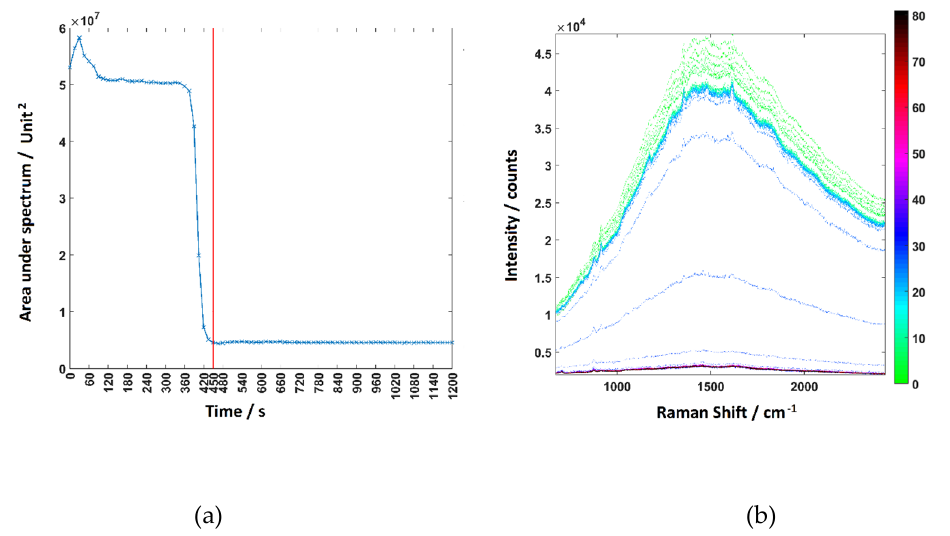
Figure A3. ( a ) The area under the curve of each spectrum in (b) plotted against time. ( b ) Raman spectra of the fluid in the channel acquired at each time point during the flow rate test. The highest curve is the pure RPMI 1640 and the lowest is the pure DPBS.